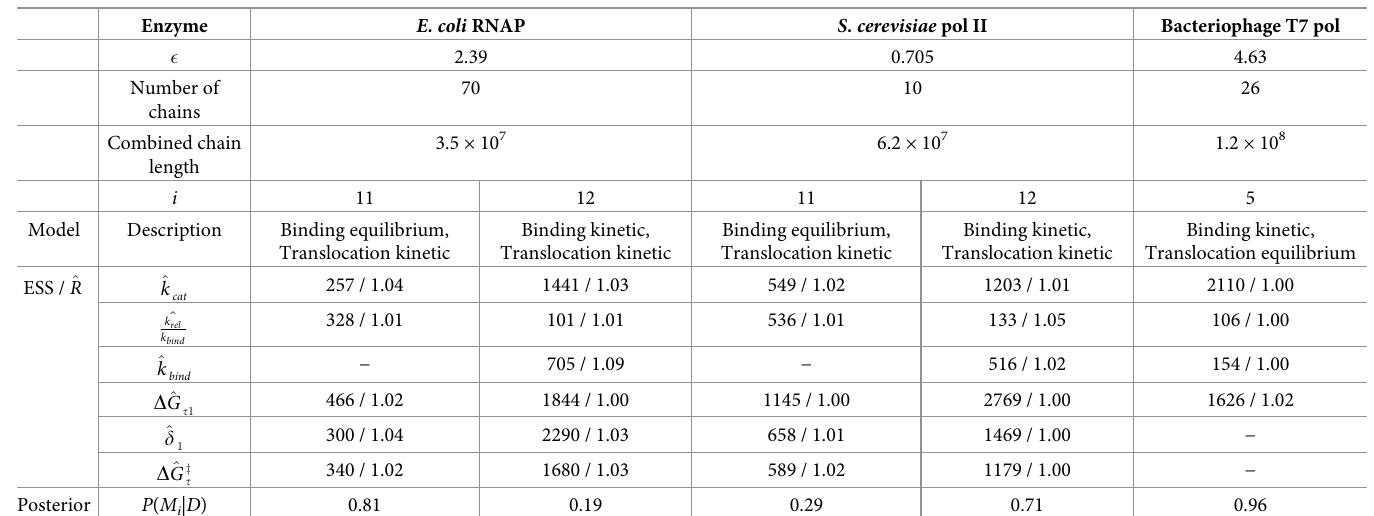
Table 2. Summary of MCMC-ABC